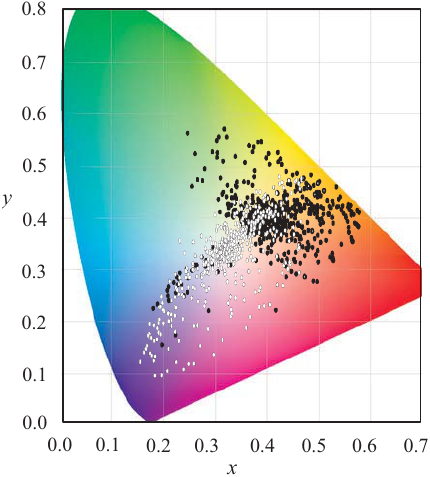
Figure 2. Example chromaticity diagram. • : gold. ◦ : fused silica in